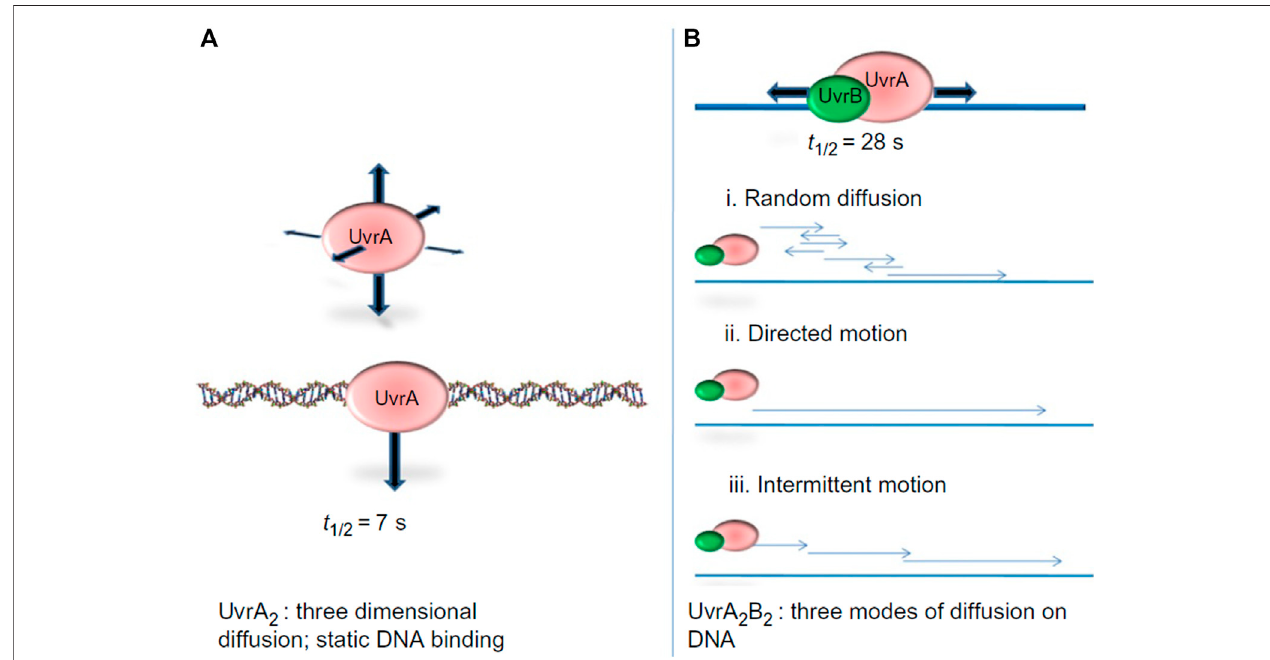
FIGURE 5 | UvrA 2 and UvrA 2 B 2 complexes use different search strategies for fi nding damage. (A) Analysis of Qdot labeled UvrA showed that it performed a 3D- search and showed static binding of t 1/2 of 7 s. (B) The UvrAB complex showed complex search behaviors on the DNA, including random linear diffusion, directed motion in the presence of ATP, and intermittent motion where the complex would pause sliding on the DNA for brief intervals. By combining a 3D search down with a1D search, UvrAB molecules are capable of ef fi ciently searching the entire E. coli genome. Figure adapted with permission from (Kad and Van Houten,